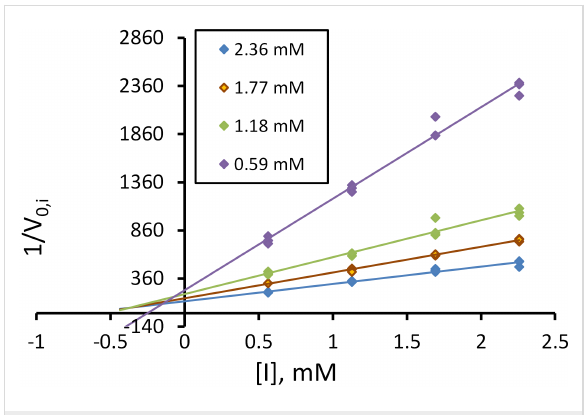
Figure 1: Dixon plot for the hydrolysis of Gly-Phe- p NA substrate cata- lyzed by bovine cathepsin C in the presence of 9b ( T = 37 °C, pH 5.0).